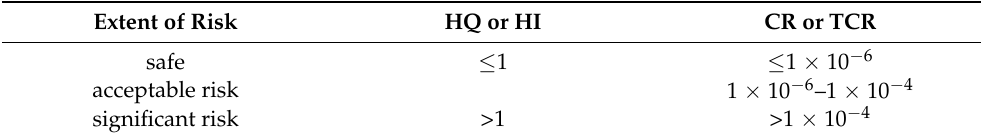
Table 3. Evaluation criteria of non-carcinogenic risk and carcinogenic risk.